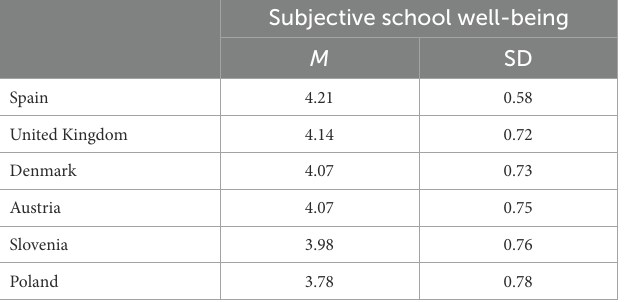
TABLE 5 Migrant adolescents’ subjective school well-being. Subjective school